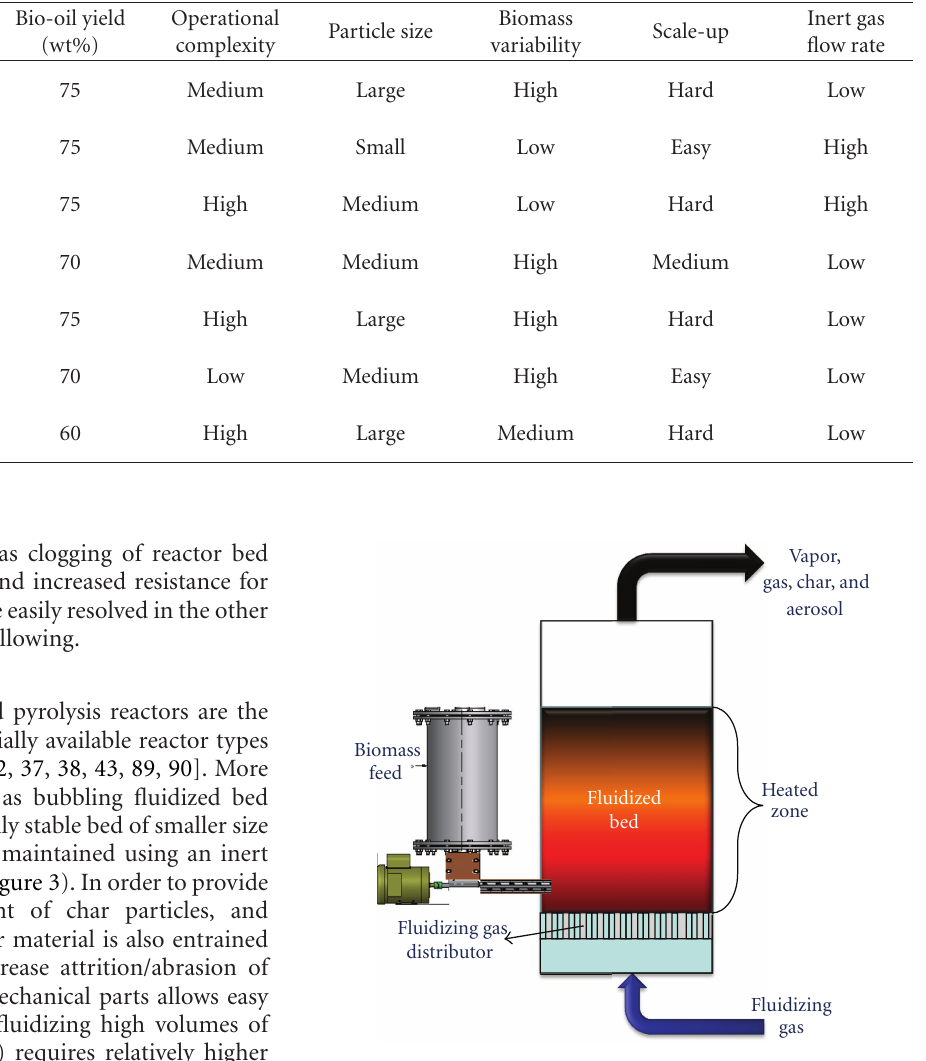
Figure 3: Generalized diagram for fluidized bed reactors for bio- mass